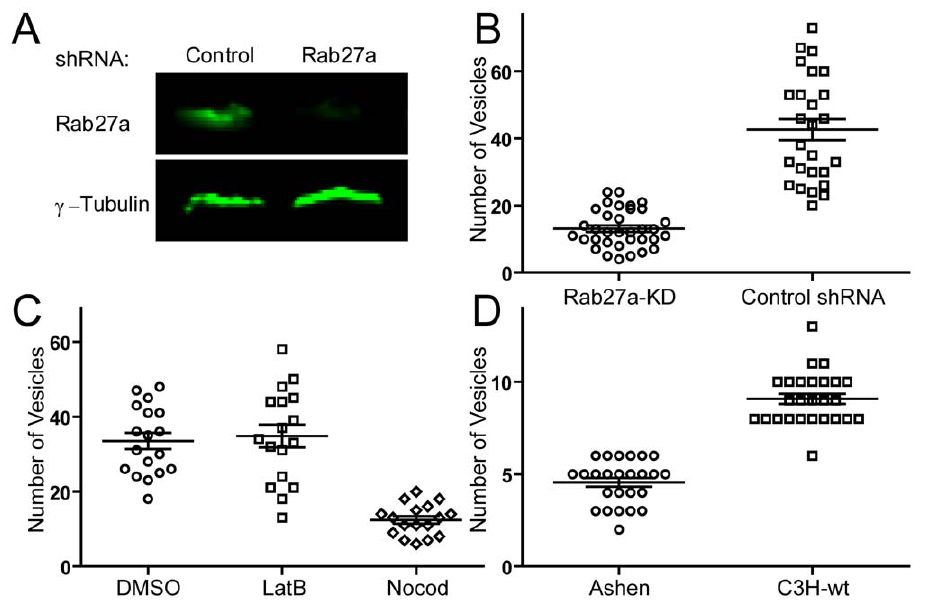
Figure 1. Knockdown of Rab27a and disruption of microtubules decreased the number of granules docked at the PM. (A) Knockdown of Rab27a expression in NKL cells. The shRNA against Rab27a was stably transfected into NKL cells. Rab27a was detected by Western blot and visualized by Odyssey Infrared Imaging (Li-Cor Biosciences). (B) Number of granules within evanescent filed per NKL cell between control shRNA and Rab27a knockdown (Rab27a-KD) visualized by TIRF microscopy. (C) Number of granules within evanescent filed per NKL cell pretreated with 10 m M Latrunculin B (LatB) and Nocodazole (Nocod). (D) Number of acidic compartments within evanescent filed per NK cell from Ashen (Rab27a mutation) and C3H (wild-type) mice. The data are representative of at least 50 cells in three independent